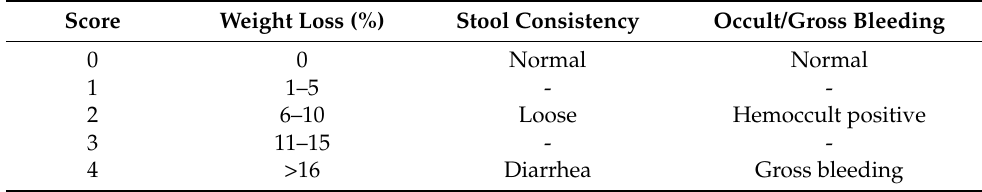
Table 1. Disease activity index scoring system. Score Weight Loss (%) Stool Consistency Occult/Gross Bleeding 0 0 Normal